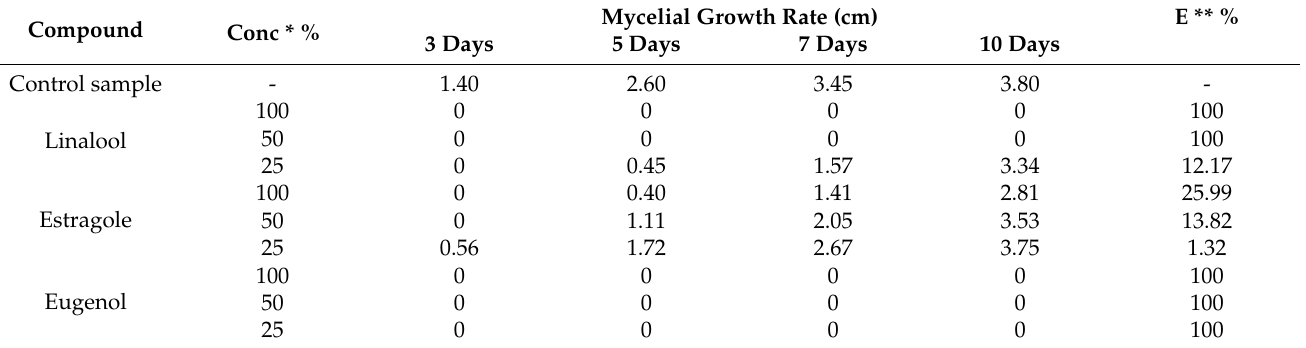
Table 6. Fungal growth inhibition efficacy of compounds against phytopathogenic Botrytis cinerea